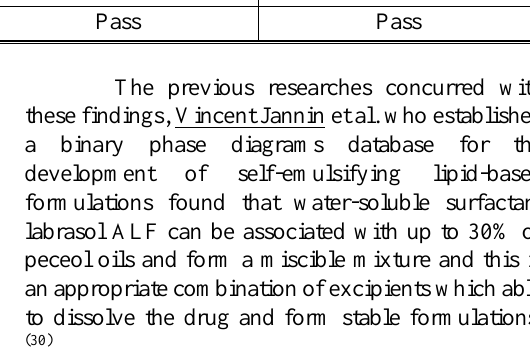
Table 4. Robustness to dilution of various tacrolimus liquid self-microemulsifying drug delivery systems Formula